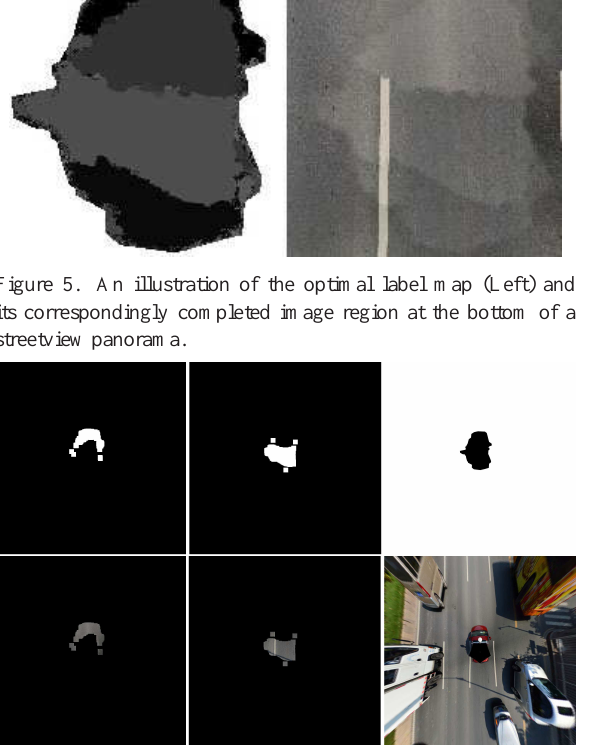
Figure 6. The mask maps corresponding to three labels in the top row and the corresponding sub-images in the bottom